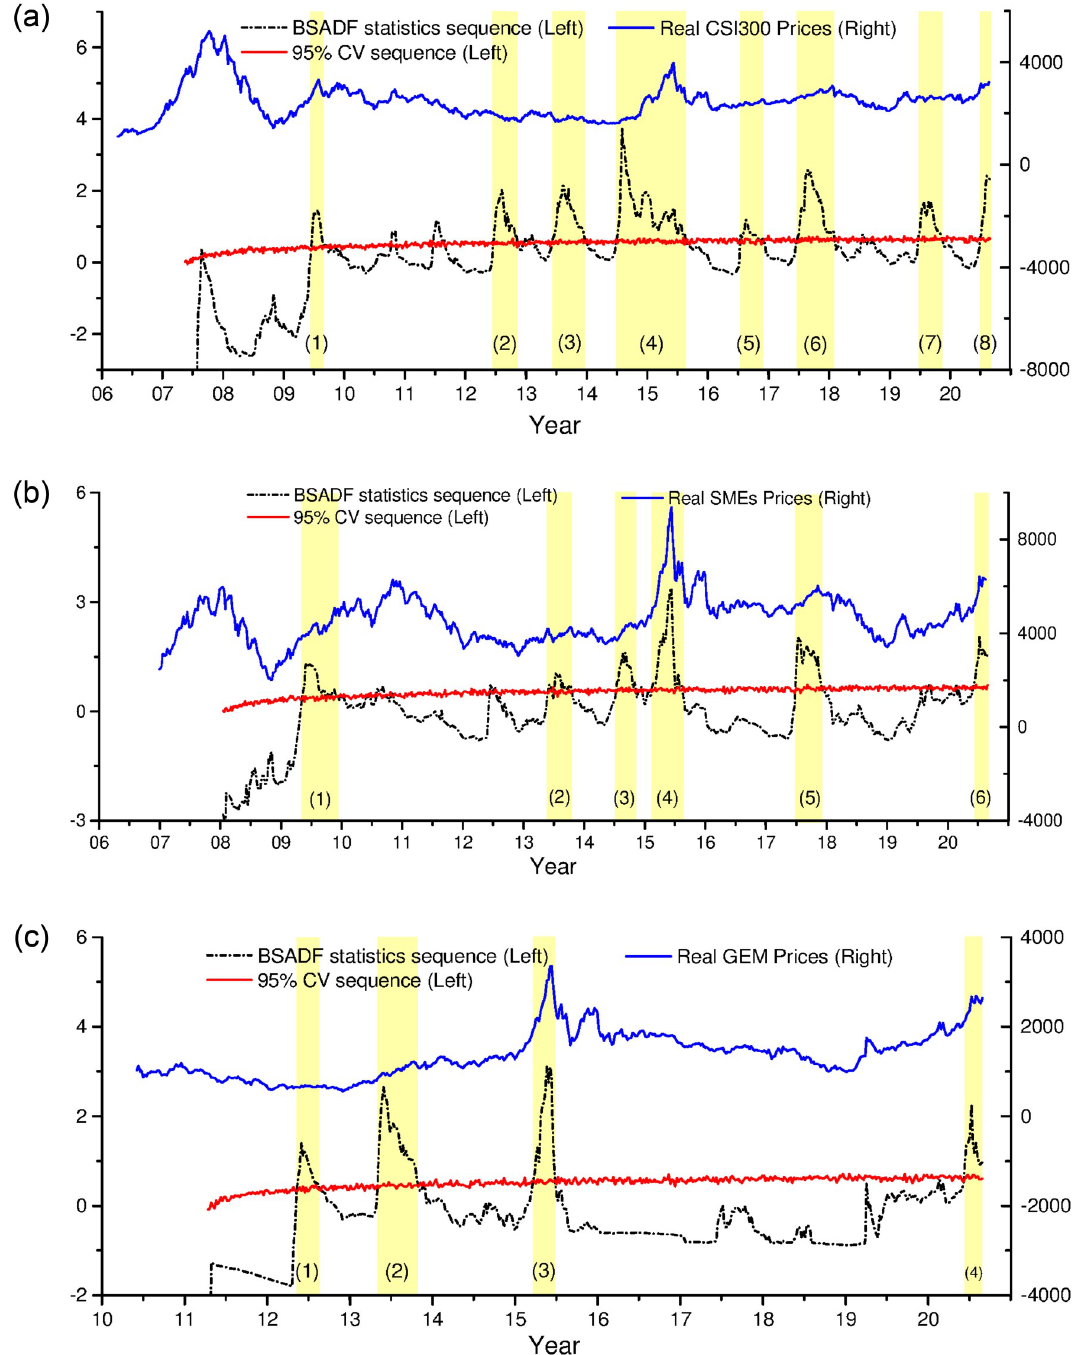
Fig 6. BSADF time-stamping results. This figure plots the BSADF statistic series (left scale), simulated 95% critical value series (left scale), and real price series (right scale) for three sectors: (a) CSI 300, (b) SMEs, and (c) GEM.